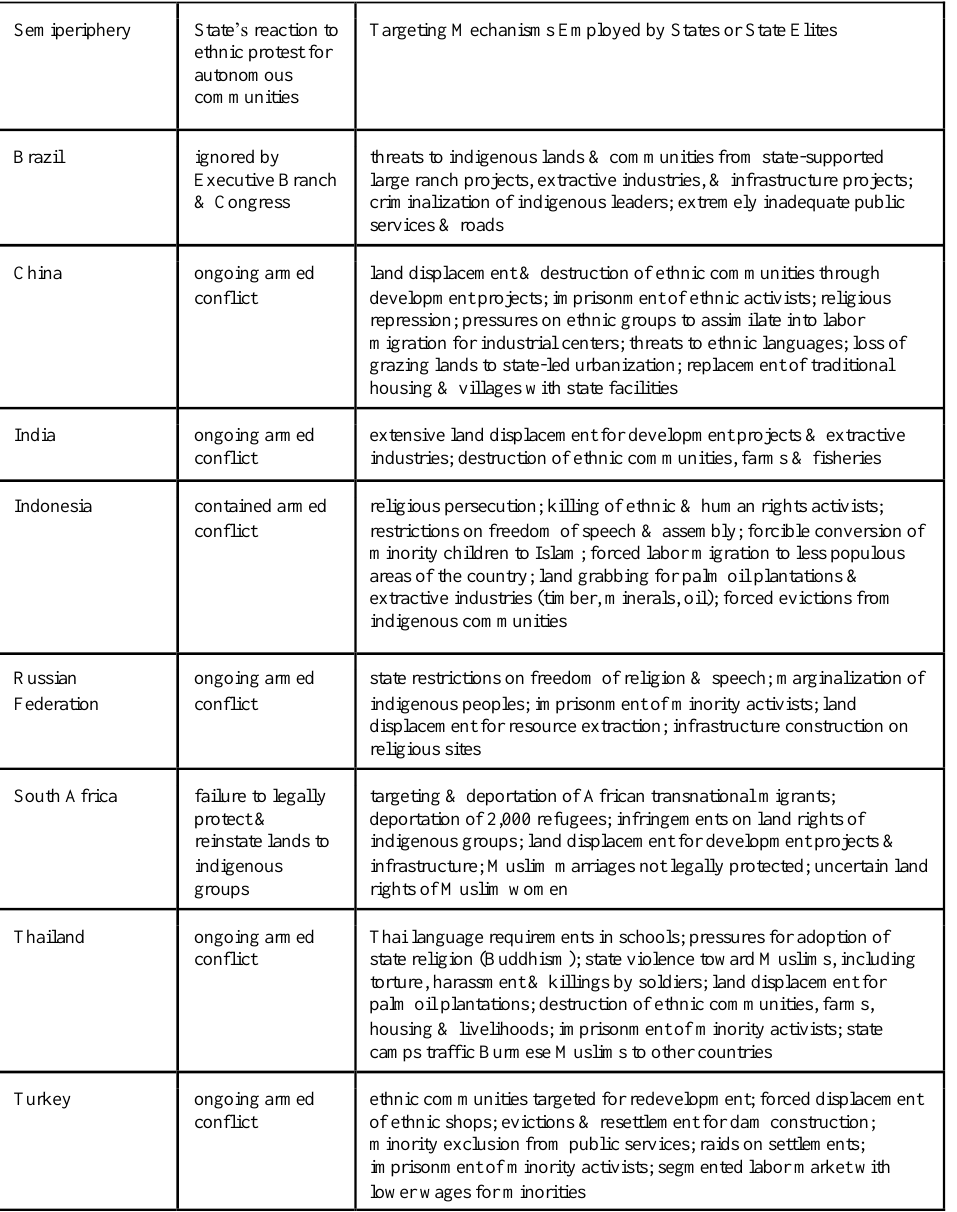
Source : Analysis of Minority Rights Group International